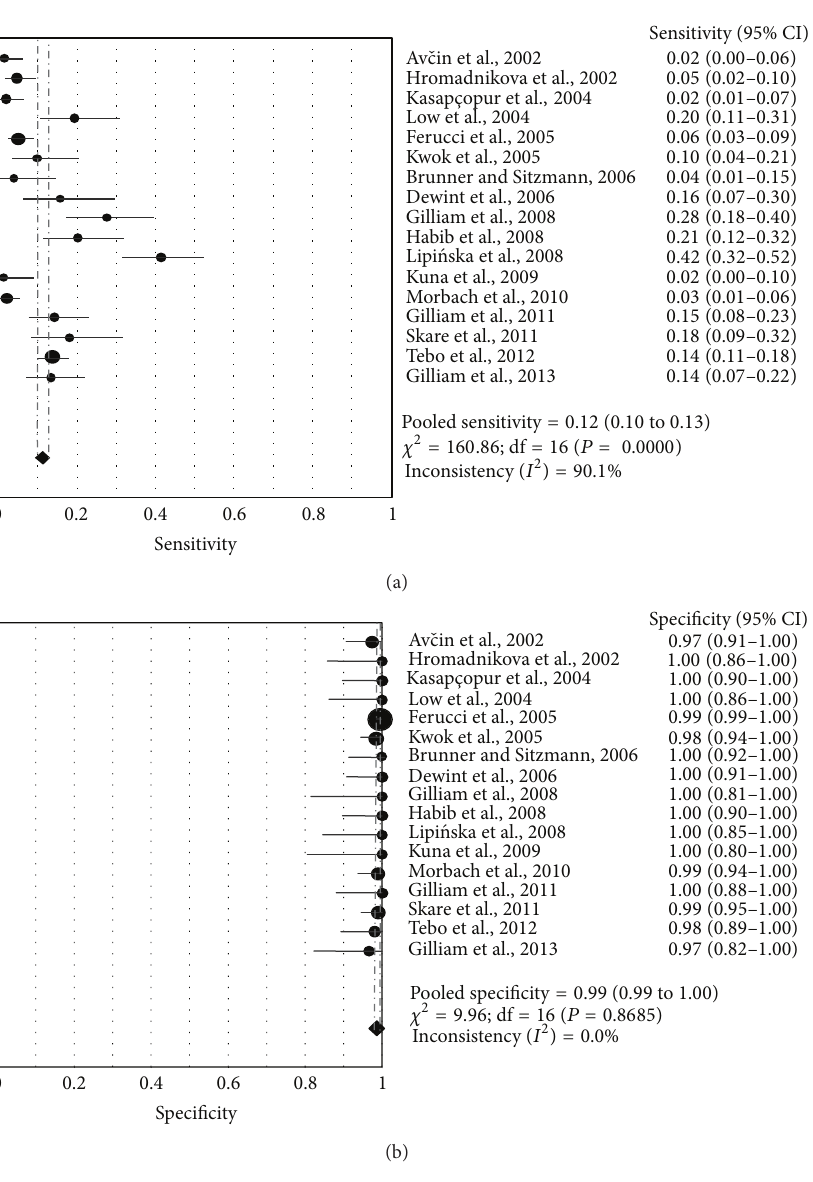
Figure 3: Sensitivity (a) and specificity (b) plots for anti-CCP antibody test in the diagnosis of JIA. Only the first author of each study is given. The circles represent the sensitivity and specificity of one study and the black line its confidence interval. The diamond at the bottom of each plot is the pooled sensitivity or specificity